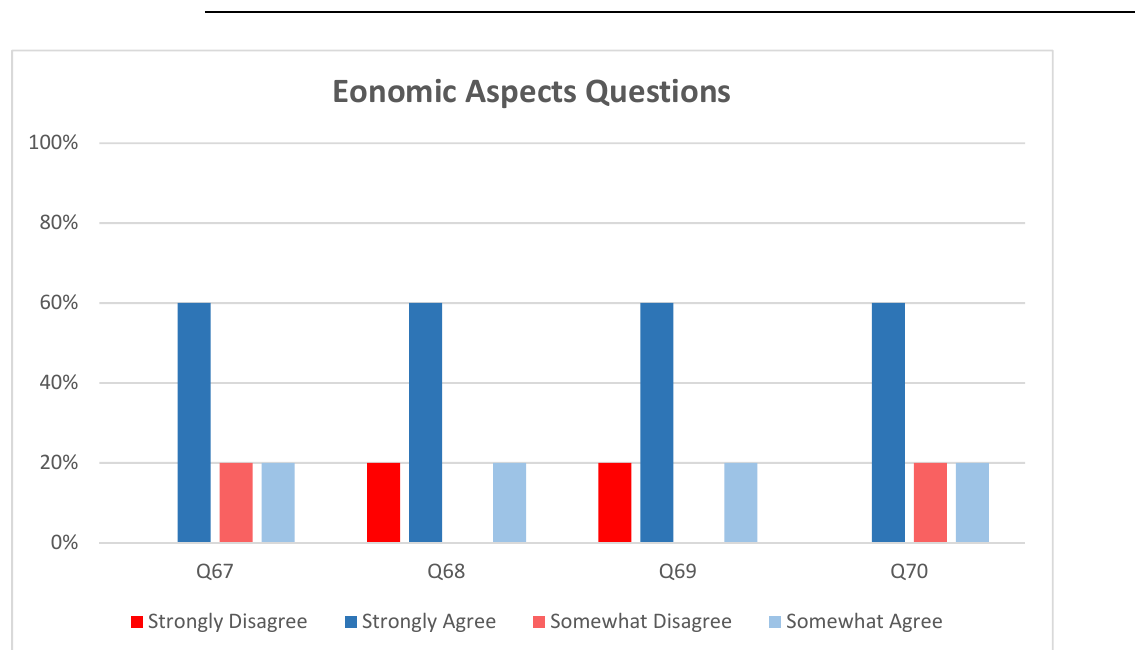
Figure 18. Results for the questions on economic aspects.